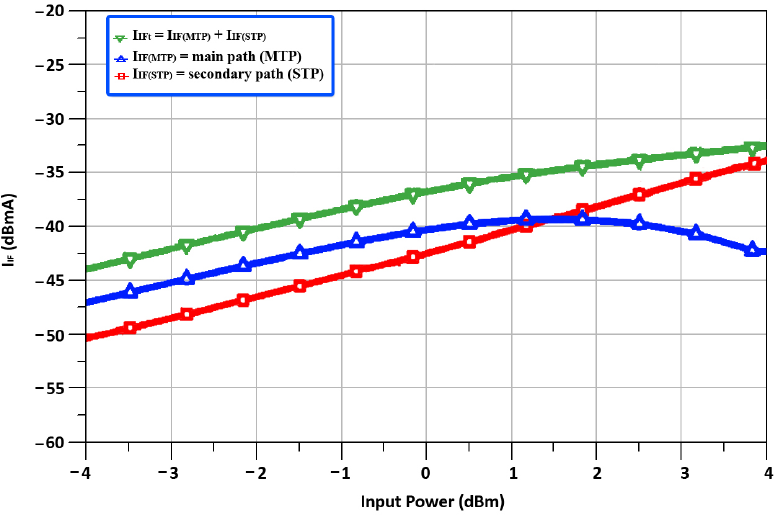
Figure 5. Output currents of duplex transconductance path